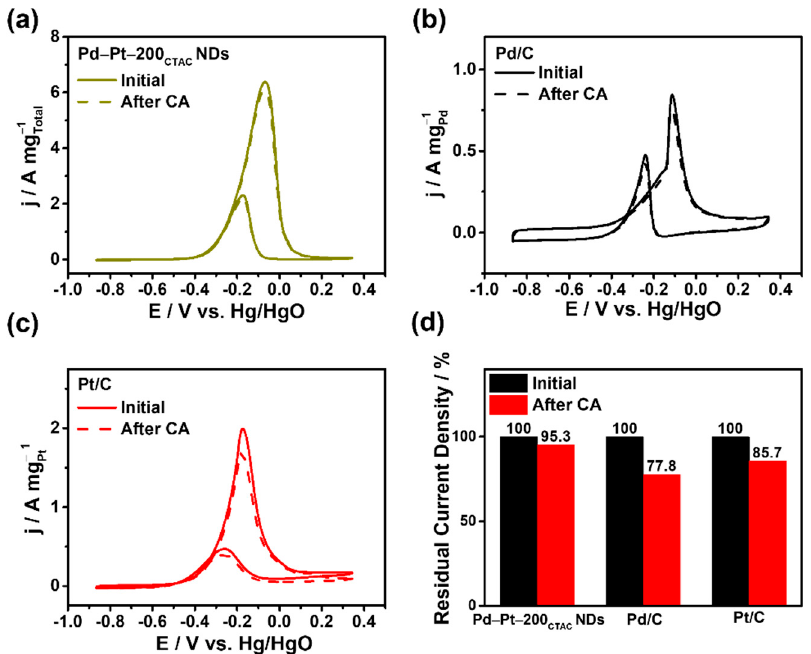
Figure 7. MOR residual current density activities of ( a ) Pd–Pt–200 CTAC NDs, ( b ) Pd/C and ( c ) Pt/C after chronoamperometry experiment for 30 min. ( d ) The percentage residual current density before and after chronoamperometry measurement.